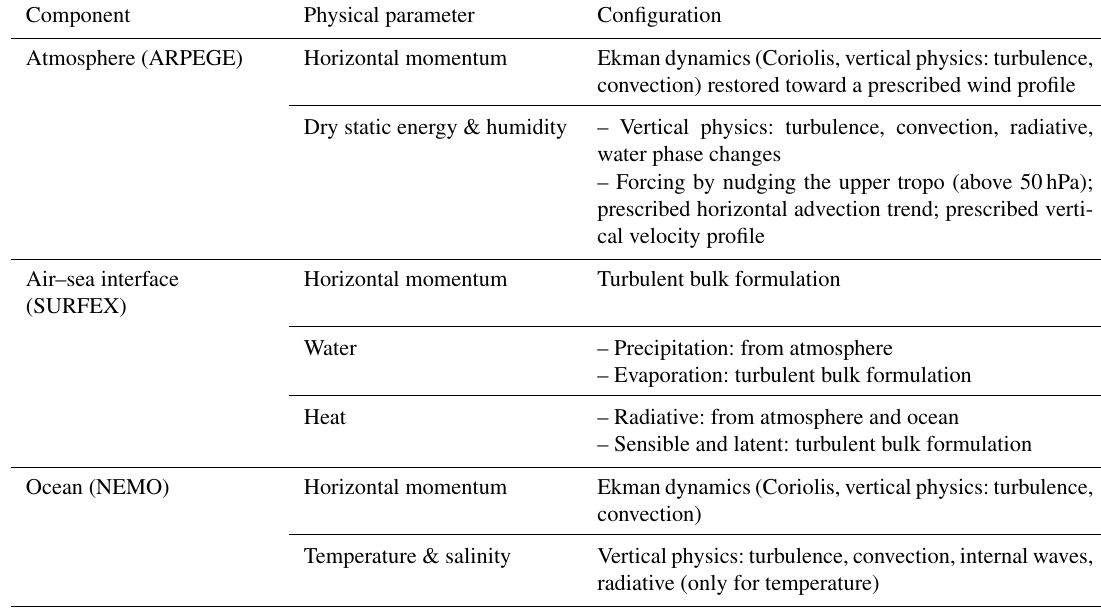
Table 1. Physical configuration of CNRM-CM6-1D.